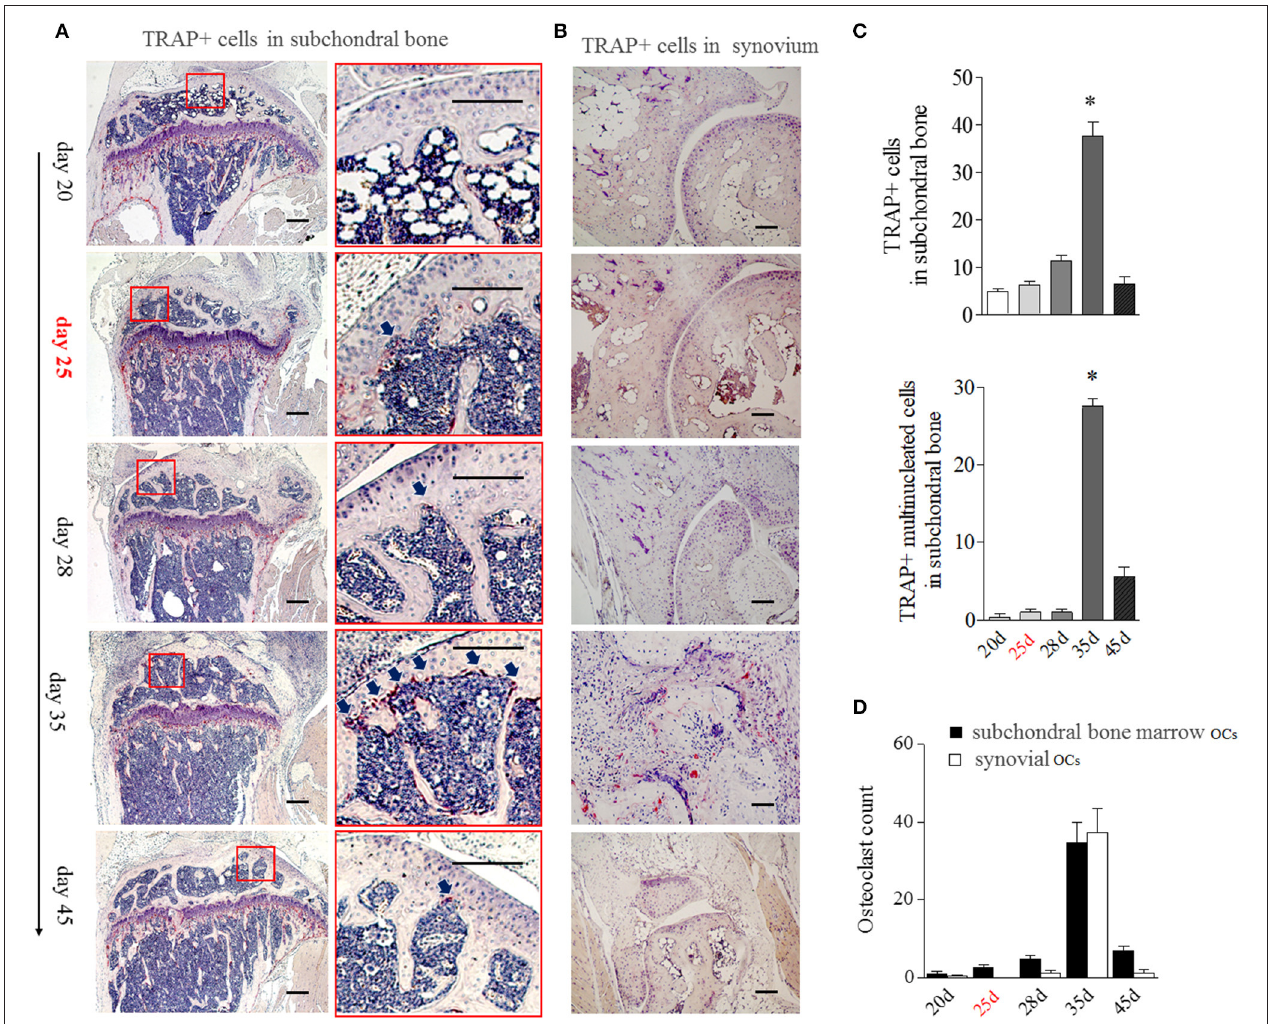
FIGURE 4 | BME links to the aggregated OCs in bone marrow adherent to the subchondral bone surface. (A) Representative image of TRAP positive cells in subchondral bone ( n = 5). The region with the solid line indicates areas of interest to be enlarged in the right image. Arrows indicate TRAP positive cells. (B) Representative image of TRAP positive cells in synovium ( n = 5). (C) Graphs show the quantitation data of image A. Values are means ± SD (* p < 0.05, compared with day 20). (D) The OCs count in subchondral bone marrow and in synovium. The first time of BME appearance during the CIA process was marked with red. All experiments were repeated three